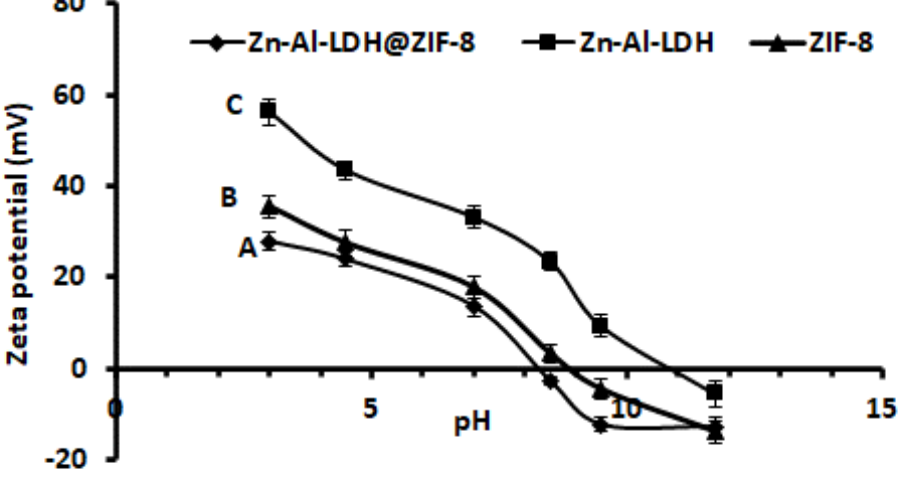
Figure 6. Graph of pH vs. zeta potential for ( A ) Zn−Al−LDH@ZIF−8 nanocomposite, ( B ) ZIF−8 and ( C ) Zn−Al−LDH